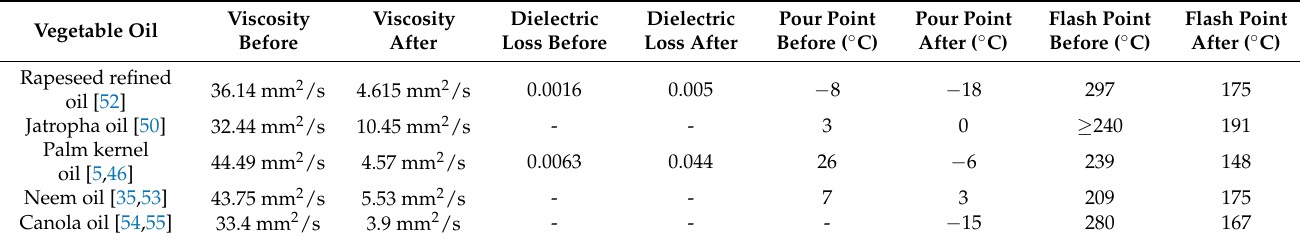
Table 2. Some properties of oil before and after transesterification.